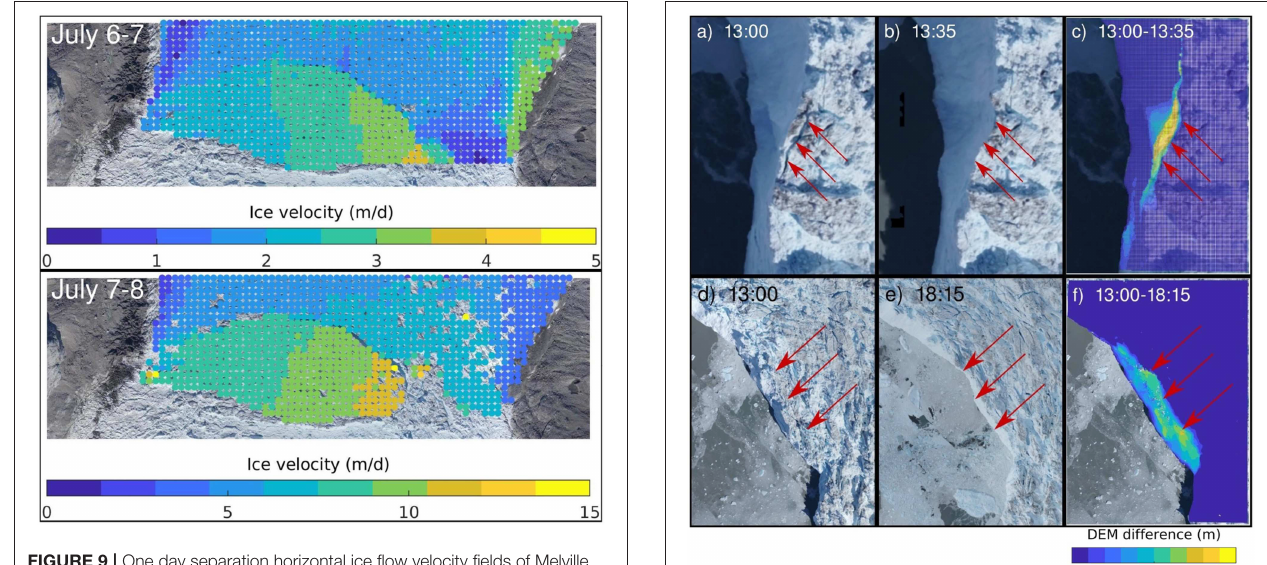
FIGURE 9 | One day separation horizontal ice flow velocity fields of Melville glacier obtained from the three first ortho-images of Figure 8 . Note that the range of the color bar varies.